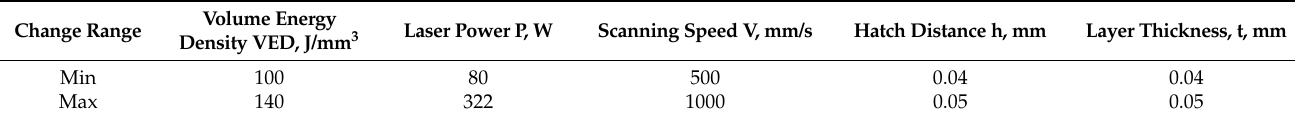
Table 1. The levels of experimental plan 6 2 × 3 2